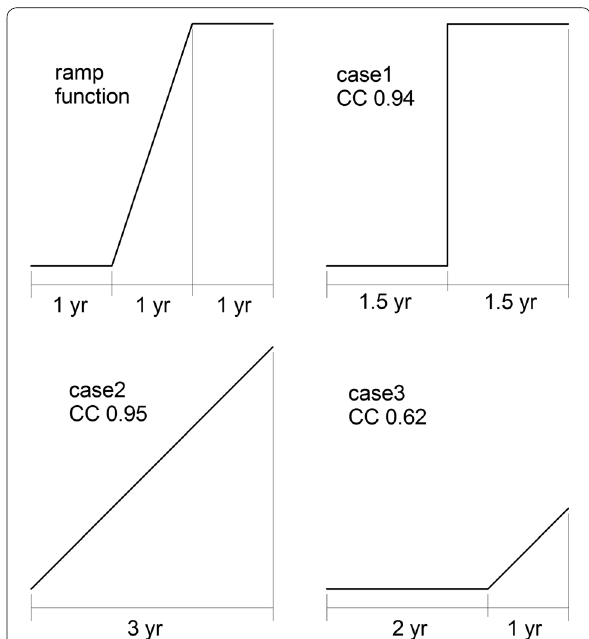
Fig. 5 Ramp function and examples of cross-correlation. The ramp function at the upper left is the one used in this study, and the other plots are examples of displacement time series showing their correla- tion coefficient (CC) with respect to the ramp function